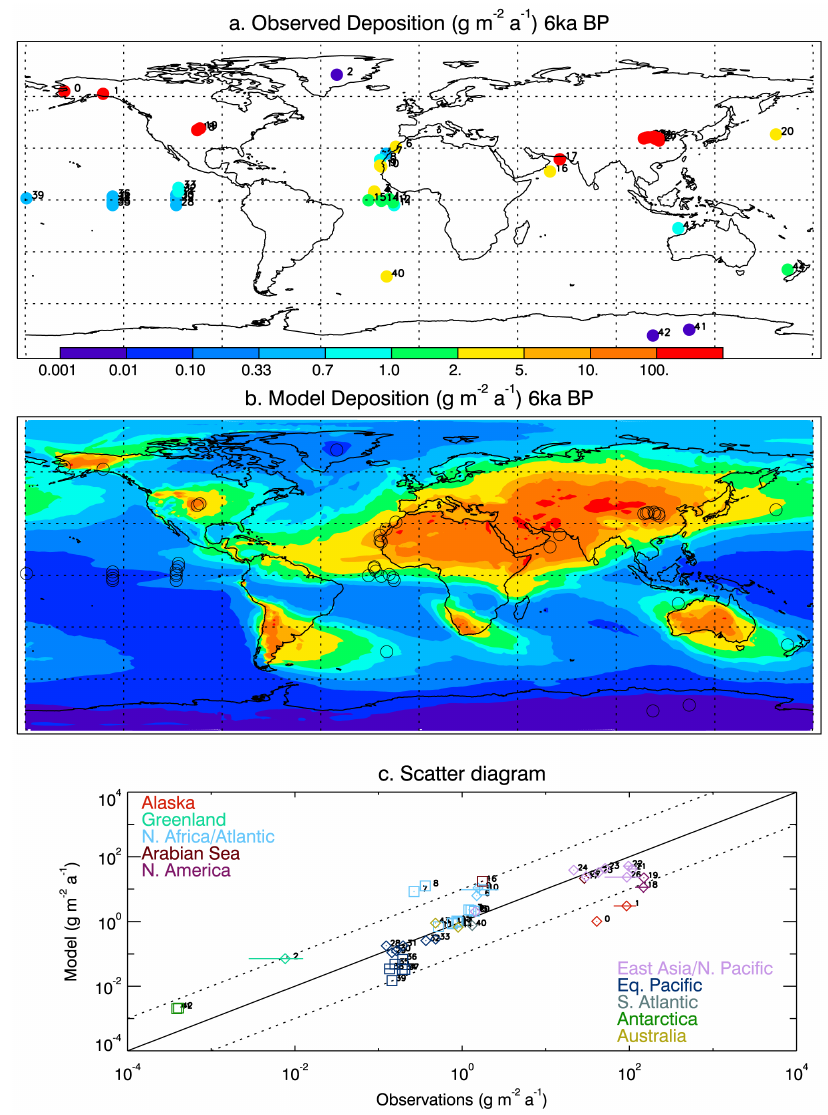
Figure 16. Comparison of simulated dust deposition (gm − 2 a − 1 ) for the 6kaBP case compared to observational estimates of the fine (<10µm) eolian mass accumulation rate for the period 5–7kaBP: observations (top); model (middle); model (bottom) versus observations scatterplot. Horizontal bars represent the variability in observational data averaged within the 5–7kaBP time lapse (1 σ ). Locations of observational sites are clustered in the scatterplots based on their geographical location, as indicated by the color-coding. In the bottom scatterplot, squares indicate high confidence level, and diamonds represent medium confidence